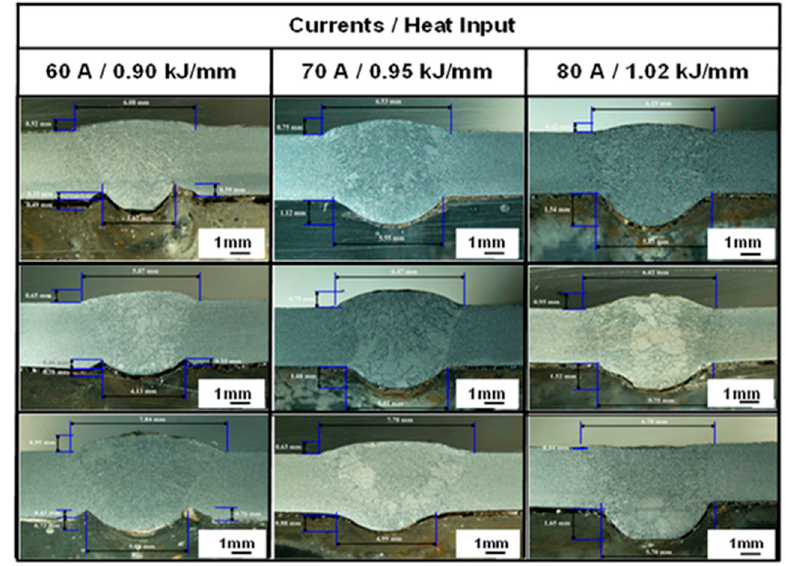
Figure 10. Characteristic shapes of welds .